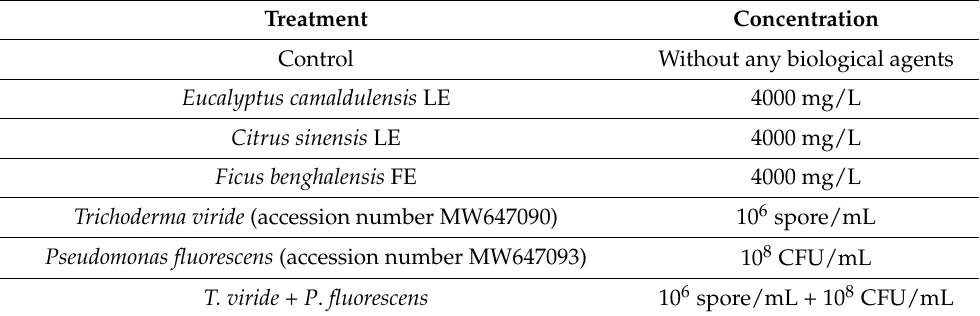
Table 1. Treatments used in the greenhouse experiment.